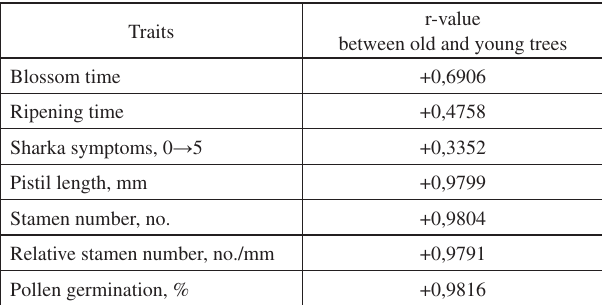
Table 5. Relationship of age of trees and traits in plums Traits